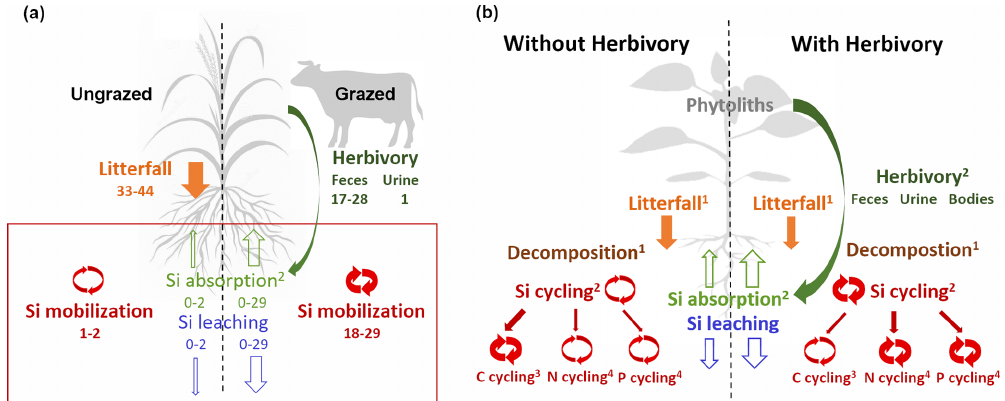
Figure 3. (a) Schematic of Si fluxes (kgha − 1 yr − 1 ) in hypothetical ungrazed and grazed grassland, dominated by cows, adapted from